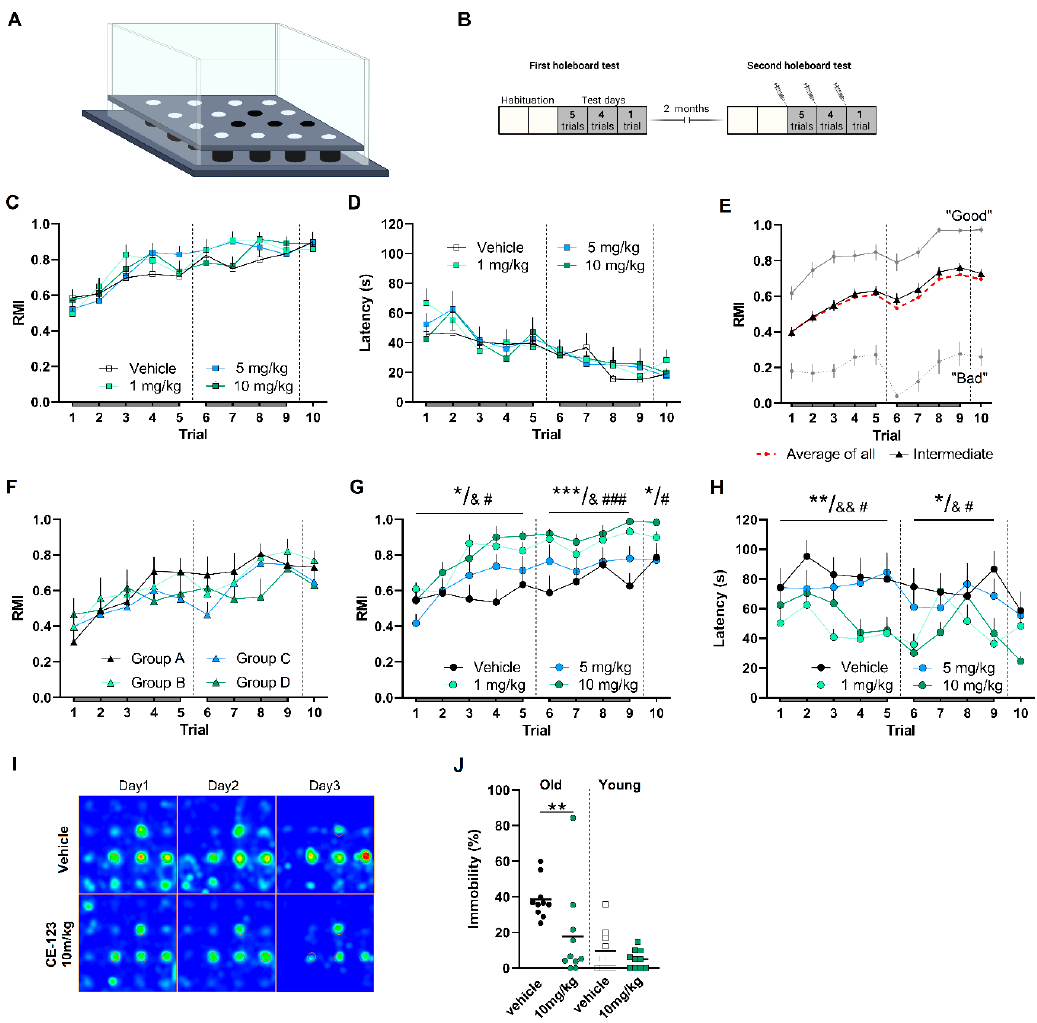
Figure 3. ( A ) Schematic of the hole-board maze, a non-sophisticated paradigm for the evaluation of reward-motivated spatial learning and memory. ( B ) A cartoon depicting the timeline of experiments. ( C,D ) Performance of young rats (5 months) treated with S-CE-123 at 1, 5 and 10 mg/kg body weight or vehicle in hole-board task. There were no significant differences in ( C ) RMIs (F 3,36 = 0.4642, p = 0.7090, two-way RM-ANOVA) or ( D ) latency (F 3,36 = 0.1431, p = 0.9335, two-way RM-ANOVA) between four groups (n = 10/group). ( E ) A large cohort of 22–24 months old rats (n = 160) [34] was behaviorally characterized using a hole-board test and based on their mean RMIs derived from trial 6 and 10, rats were characterized as impaired, unimpaired or “intermediate”. Thirty-eight “intermediate” rats of age 22–23 months were selected, randomly grouped and used for treatment. ( F ) Four groups of aged rats were equal in terms of RMIs in the first hole-board test. ( G – I ) Performance of old (24–25 months) rats treated with S-CE-123 at 1, 5 and 10 mg/kg body weight or vehicle in hole-board task (n = 9–10/group). There was a significant treatment effect with improved ( G ) RMIs (day1 (F 3,34 = 4.050, p = 0.0145, two-way RM-ANOVA), day2 (F 3,34 = 8.021, p = 0.0004, two-way RM-ANOVA); day3 (F 3,34 = 3.273, p = 0.0328, one-way ANOVA) and decreased ( H ) latency (day1 (F 3,34 = 5.405, p = 0.0038, two-way RM-ANOVA), day2 (F 3,34 = 3.698, p = 0.0209, two-way RM- ANOVA); day3 (F 3,34 = 2.281, p = 0.0969, one-way ANOVA) in S-CE-123 groups. * ANOVA general treatment effect, multiple comparison, & vehicle vs. 1 mg/kg and # vehicle vs. 10 mg/kg. ( I ) Heat map of hole visits of aged rats. ( J ) In the first trial on day1, aged S-CE-123-treated animals spent significantly less time immobile compared to vehicle treated rats ( p = 0.0038, Mann–Whitney test), whereas, in young animals, treatment had no effect on immobility ( p = 0.4988, Mann–Whitney test). Values are expressed as mean ± SEM, (*/&/# p < 0.05; **/&& p < 0.01; ***/### p <